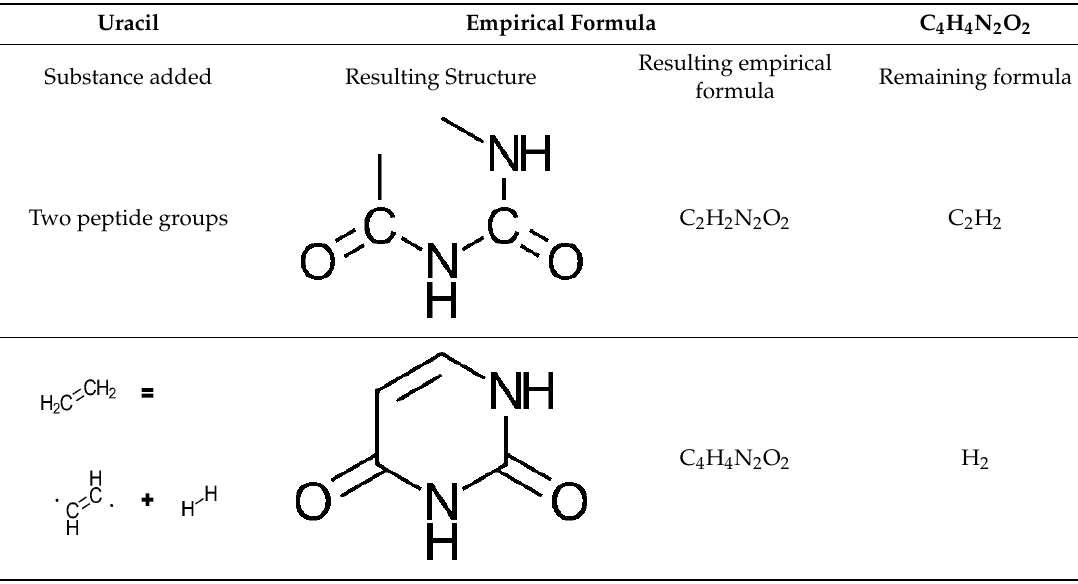
Figure 8. The structure of uracil. Table 2. The gradual growth of uracil.